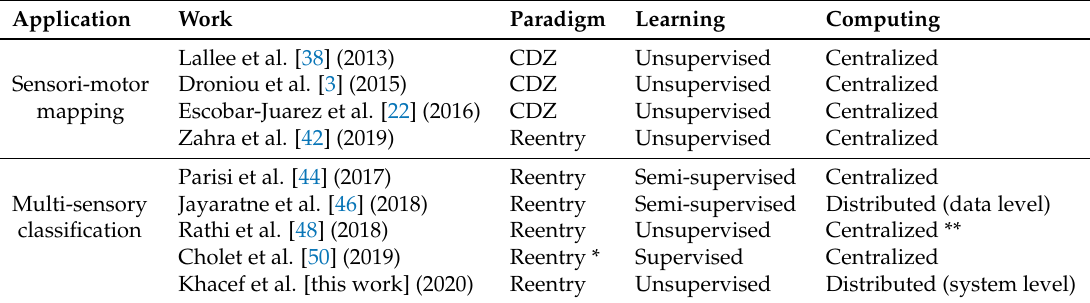
Table 1. Models and applications of brains-inspired multimodal